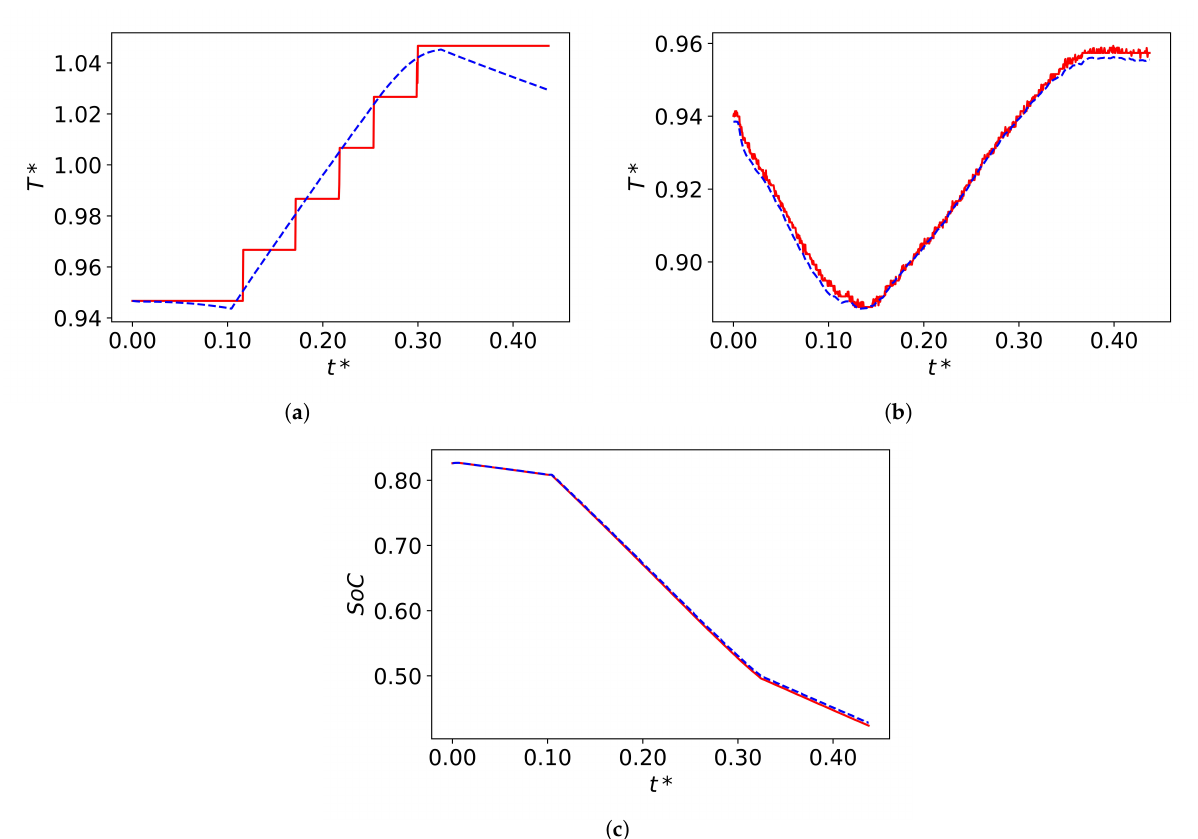
Figure 9. Results for Case 3: ( a ) average battery pack temperature, ( b ) outlet coolant temperature and ( c ) average battery pack SoC. Measured quantity ; simulated quantity .